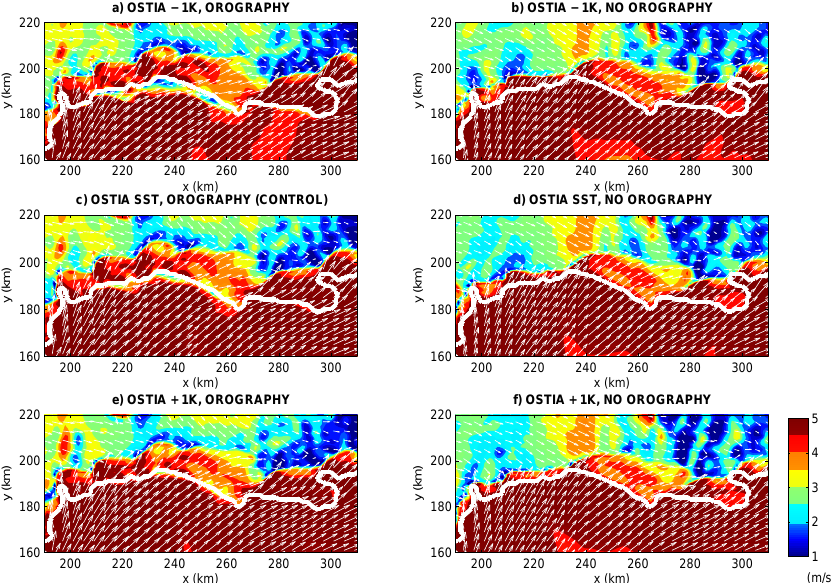
Fig. 6. Wind speed (filled contours) and vectors at 10ma.g.l. at 15:00UTC (as in Fig. 4) for the perturbed-SST experiments, with and without Figure 6. Wind speed (filled contours) and vectors at 10 m AGL at 1500 UTC (as in Fig. 4) for the perturbed-SST experiments, with and orography. (c) is identical to Fig. 4b but is included to enable direct comparison with the perturbed without orography. Panel c is identical to Fig. 4b but is included to enable direct comparison with the perturbed experiments. only evident in the runs with orography (left column, Fig. 6). breeze can be defined as the speed at which the sea-breeze The runs without orography (right column, Fig. 6) produce front advances inland (Finkele 1998).] The speed of the ex- a more uniform wind field o ff shore and there is no evidence tension of the sea breeze circulation can be inferred from the of a calm zone. The run with the coolest SST and orography slope of the curves in Fig. 7a,c and appears approximately (Fig. 6a) produces a calm zone that is broader and more pro- constant in each direction from the gridbox of earliest on- nounced than in the control run (Fig. 6c), which in turn has set. The o ff shore propagation speed is faster than the onshore a calm zone that is broader and more pronounced than in the propagation speed, as noted by Finkele (1998). run with warmest SST (Fig. 6e). The e ff ect of SST alone on The wind speeds at 1500 UTC in the Lyme Bay and Port- the surface structure of the sea breeze in the absence of orog- land Harbour sections are shown in Fig. 7b,d. In the Port- raphy is not very pronounced, as can be seen by comparing land Harbour section, the sea breeze front is advanced far-